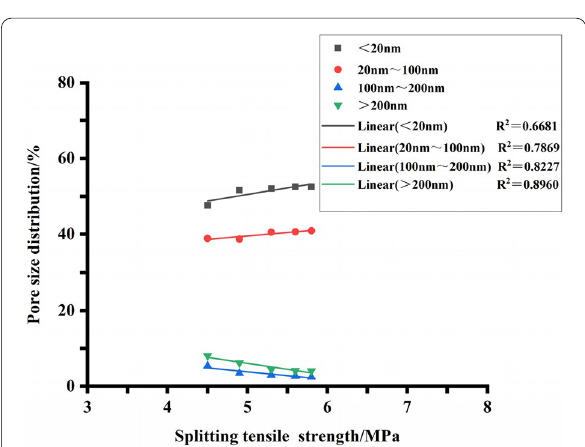
Fig. 22 Relationship between pore size distribution and compressive strength (BFRC3).